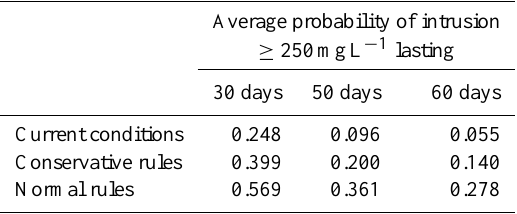
Figure 7. Relationship between long-duration, high-intensity intru- sions and duration of low discharges.